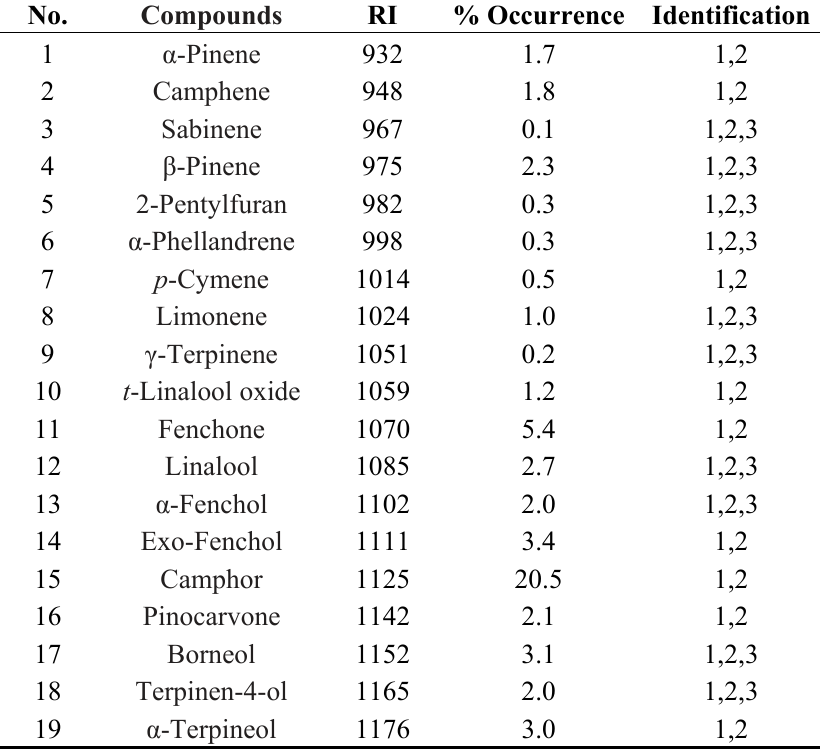
Table 1. Chemical composition of the essential oil Leucas virgata